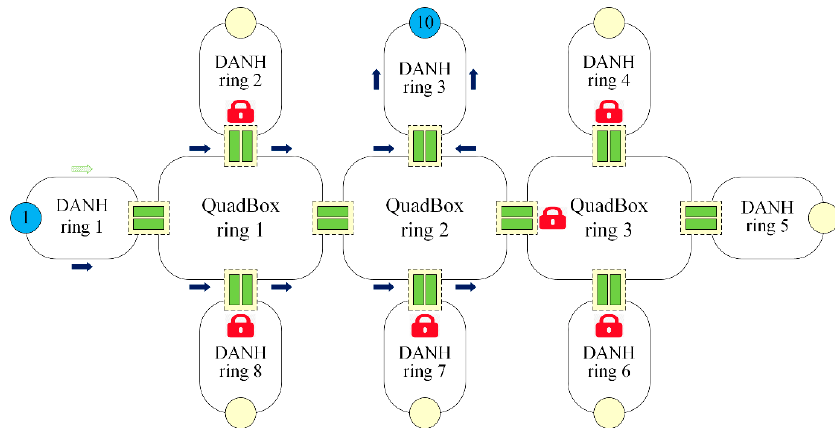
Figure 9. Forwarding the (cid:1863) (cid:1872)ℎ ( (cid:1863) ≥ 2 ) frame in eEFA.